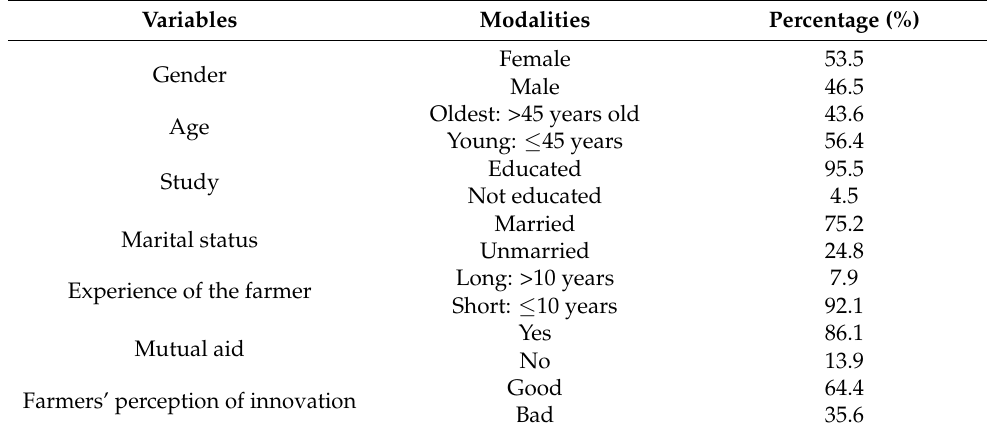
Table 3. Farmers’ socio-demographic characteristics.